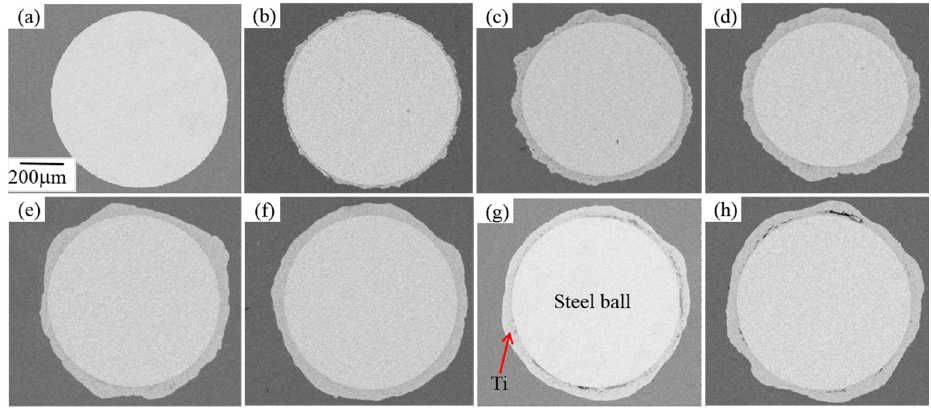
Figure 4. SEM images for cross-section of Ti samples prepared by mechanical coating at 400 rpm after different durations: ( a ) 1 h; ( b ) 4 h; ( c ) 8 h; ( d ) 12 h; ( e ) 16 h; ( f ) 20 h; ( g ) 26 h; and ( h ) 32